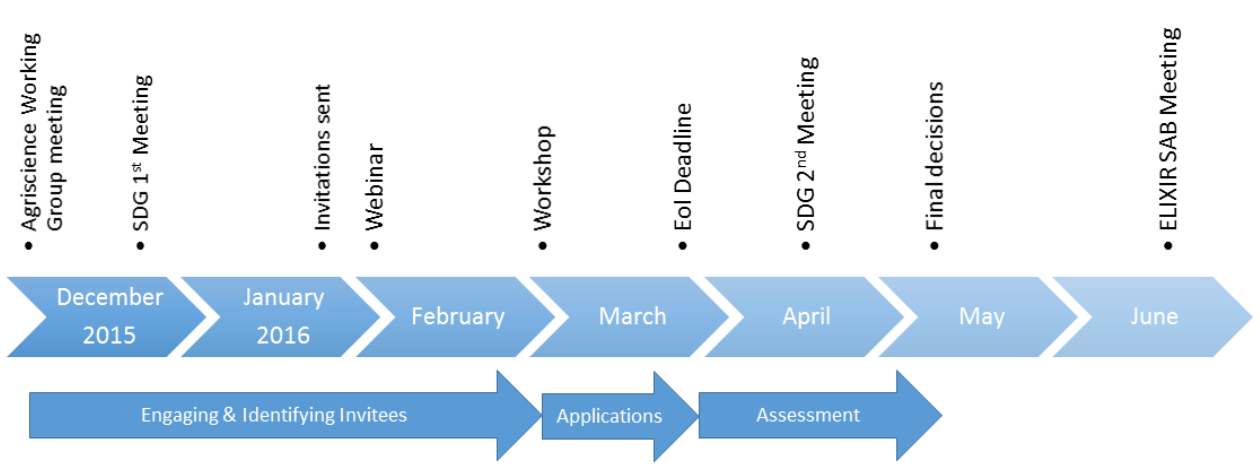
Figure 1. Summary timeline of the ELIXIR-UK Node Expansion process. Bulleted items represent milestones in the process; arrows below represent the three main phases: engaging the community and identifying potential applicants to invite (the call was also open to non-invited applications); receipt of applications; and assessment of applications by the SDG including feedback and iteration with